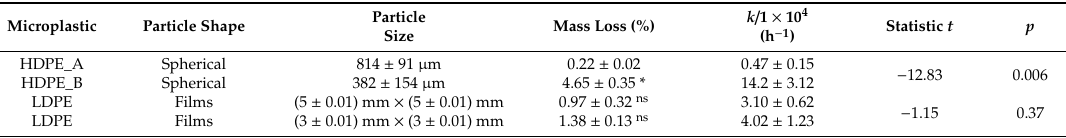
Table 2. Characteristics of MPs, their mass loss and degradation-rate constant after photocatalytic degradation by mesoporous N–TiO 2 coating. Data are mean ±